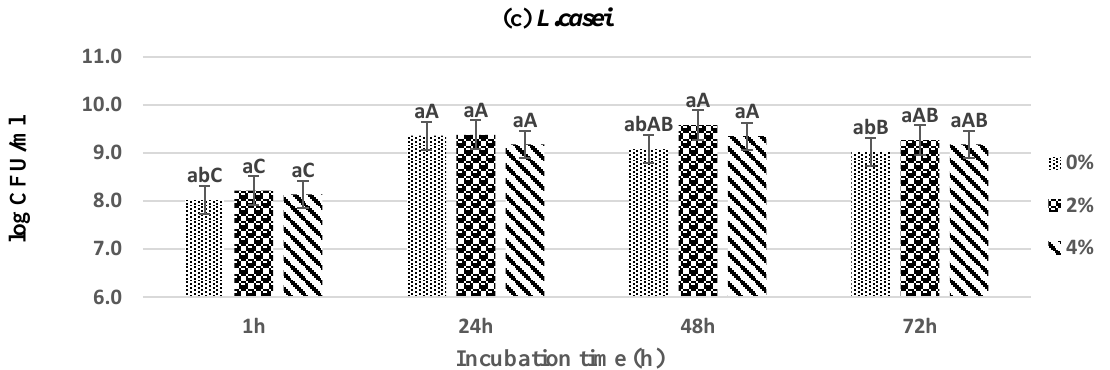
Figure 3. Prebiotic effects of different concentrations of mango peel powder (MPP) on the number (log CFU/mL) of tested individual probiotic bacteria; Bifidobacterium animalis subsp. Lactis BB-12 ( a ), Lactobacillus rhamnosus LGG ( b ) and L. casei ( c ) during 72 h of anaerobic incubation. Different lowercase letters within each incubation time and probiotic strain indicate significant difference ( p < 0.05) based on the concentration of FPP (0%, 2%, 4%) within same incubation time points and similar probiotic strain. Various uppercase letters indicate significant differences within the same concentrations at different incubation time points. Data represent mean values ± standard error ( n = 4).